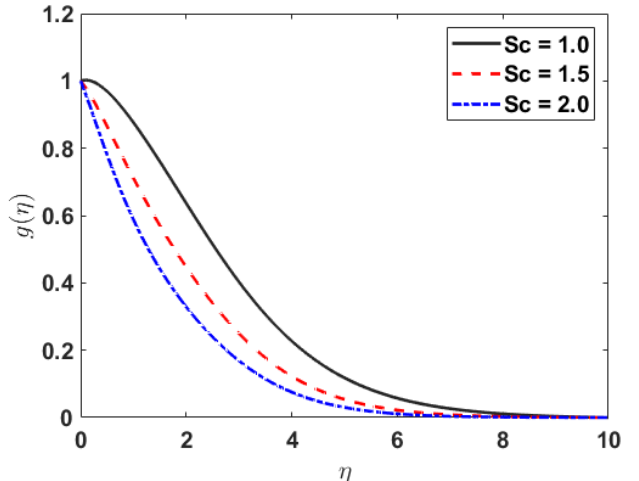
Figure 7. 𝑔(cid:4666)𝜂(cid:4667) along 𝑆𝑐 . Figure 7. g ( η ) along Sc